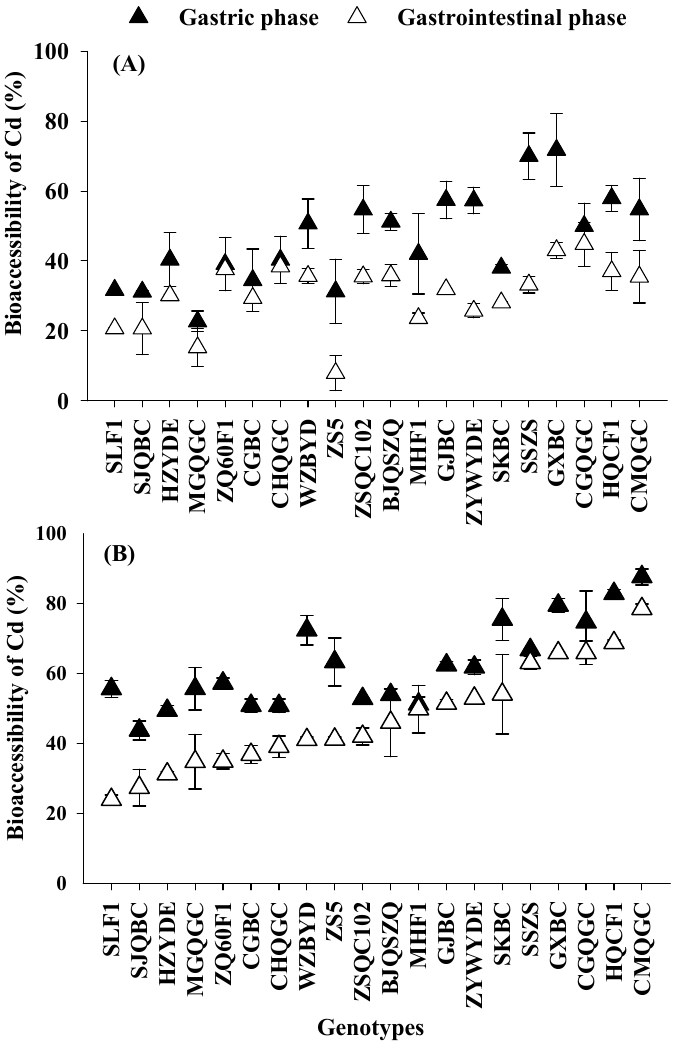
Figure 4. Cd bioaccessibility during gastric phase and gastrointestinal phase of pakchoi of 20 genotypes, grown in low-level co-contaminated soil ( A ) and high-level co-contaminated soil ( B ). Error bars depict standard errors of the means ( n = 3).